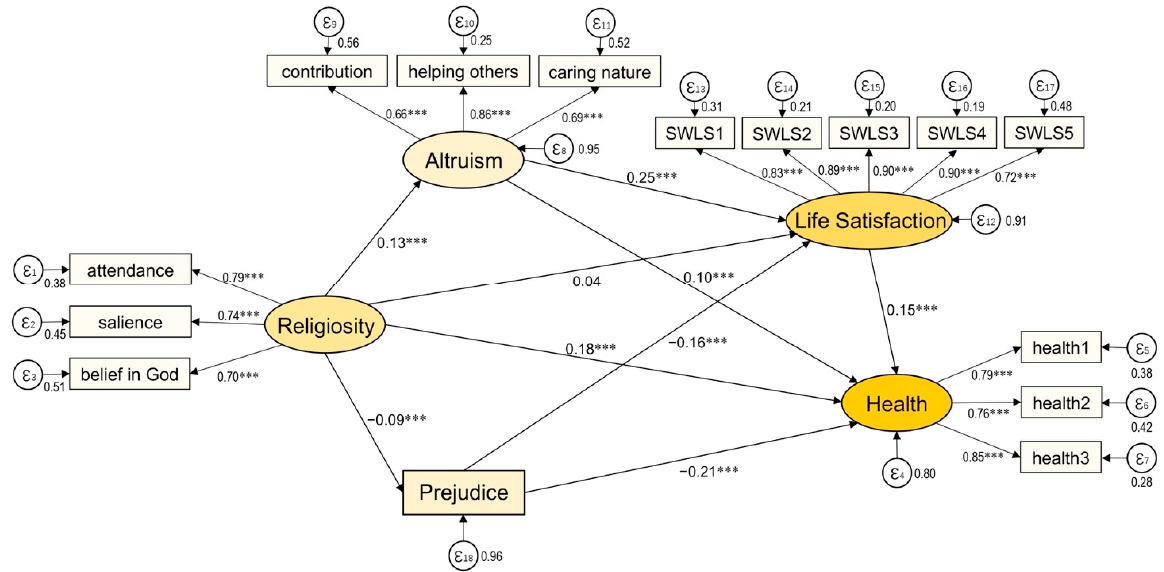
Figure 2. Chi-square ( χ 2 ) = 805.228, d.f. = 132; Root Mean Square Error of Approximation (RMSEA) = 0.040; Comparative Fit Index (CFI) = 0.973; Tucker–Lewis Index (TLI) = 0.963. All of the coefficients are standardized. The model controls for age, gender, birthplace, and education level. Note: *** p < 0.001, two-tailed.